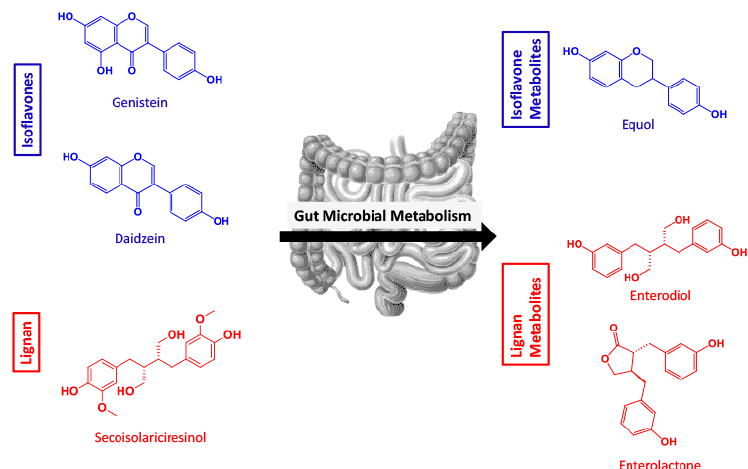
Figure 1. Overview of the polyphenol isoflavones and lignan parent compounds and their respective polyphenol microbial metabolites produced by gut microflora. (Genistein = GEN, daidzein = DAI, equol = EQ, secoisolariciresinol = SECO, enterodiol = ED, enterolactone = EL).